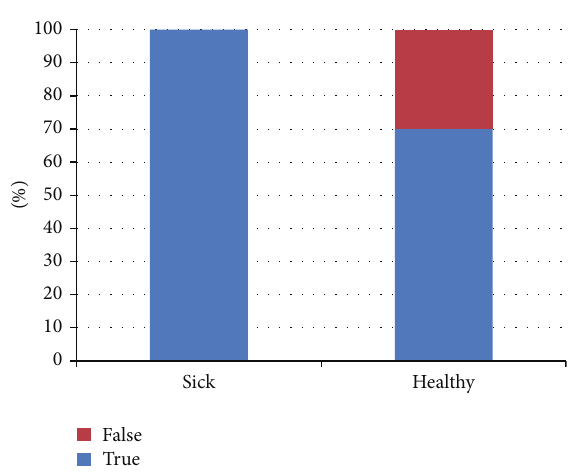
Figure 15: Experimental results,